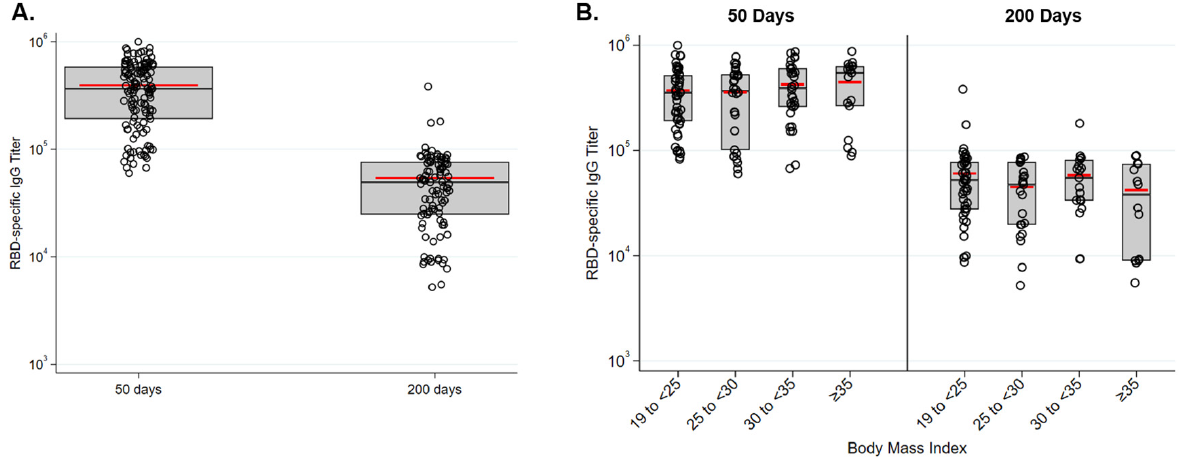
Figure 1. SARS-CoV-2 RBD-specific serum IgG endpoint dilution titers 50 and 200 days following vaccination with BNT162b2. ( A ) Antibody titers declined significantly between day 50 and day 200 ( p < 0.001). ( B ) Titers did not significantly differ at either time point in relation to the participants’ BMI.